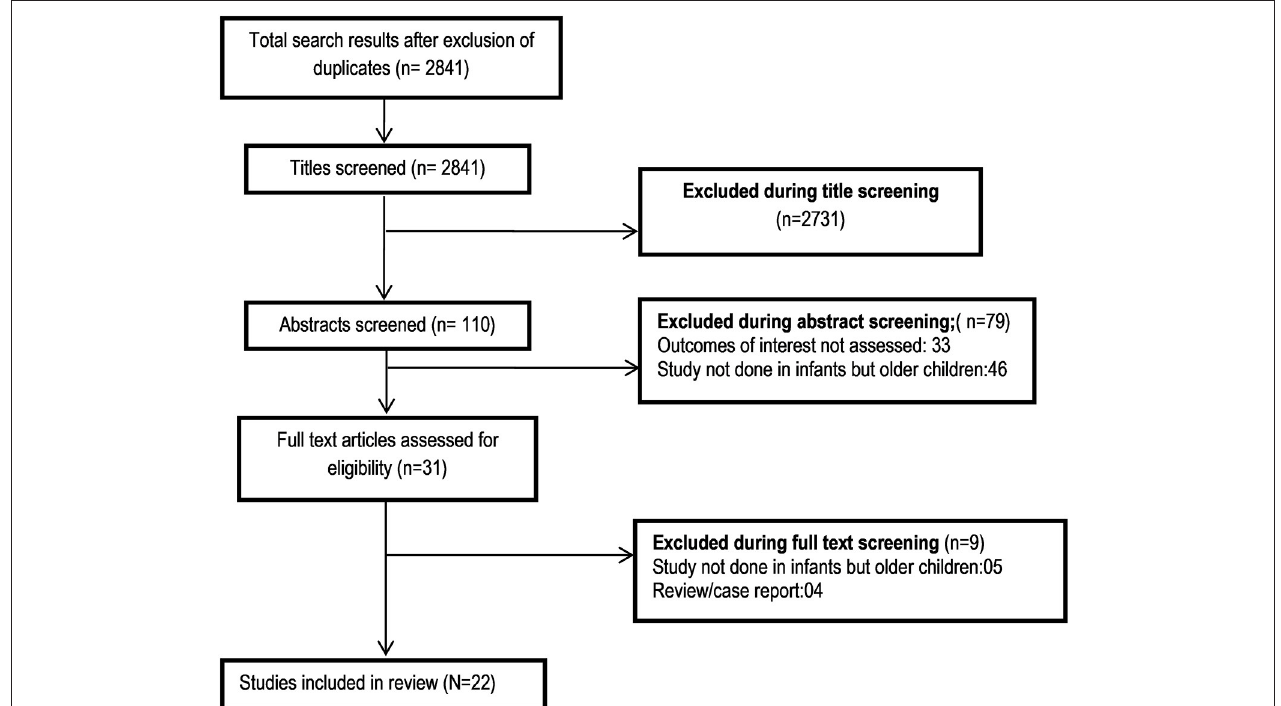
FIGURE 1 | Selection process of the studies included in the